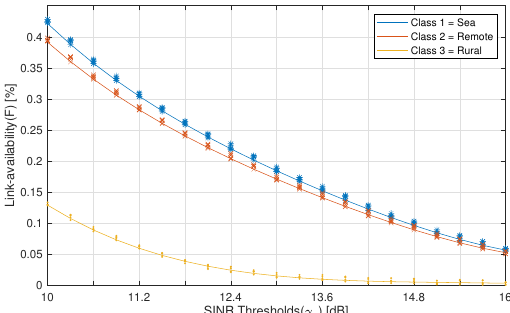
Figure 12. The link-availability at different SINR threshold when the optimal beamwidth is adopted. The markers represent the result of the simulation, while the plots are the approximation of link-availability using (18).